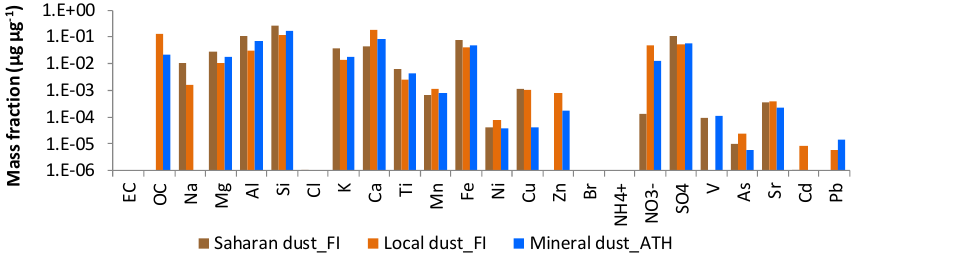
Figure 11. Source chemical profiles obtained by the application of the PMF model (Amato et al., 2016): two mineral dust sources were identified in Florence (African dust_FI and Local dust_FI) while a mixed mineral dust profile was found in Athens (Mineral dust_ATH).